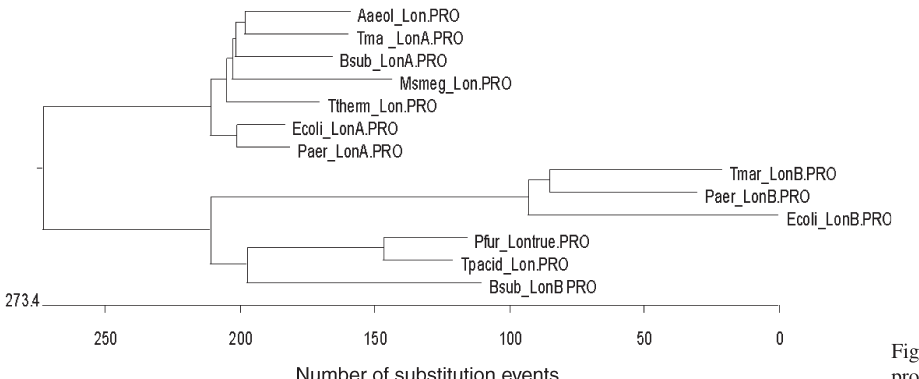
Figure 2. Phylogenetic tree of Lon